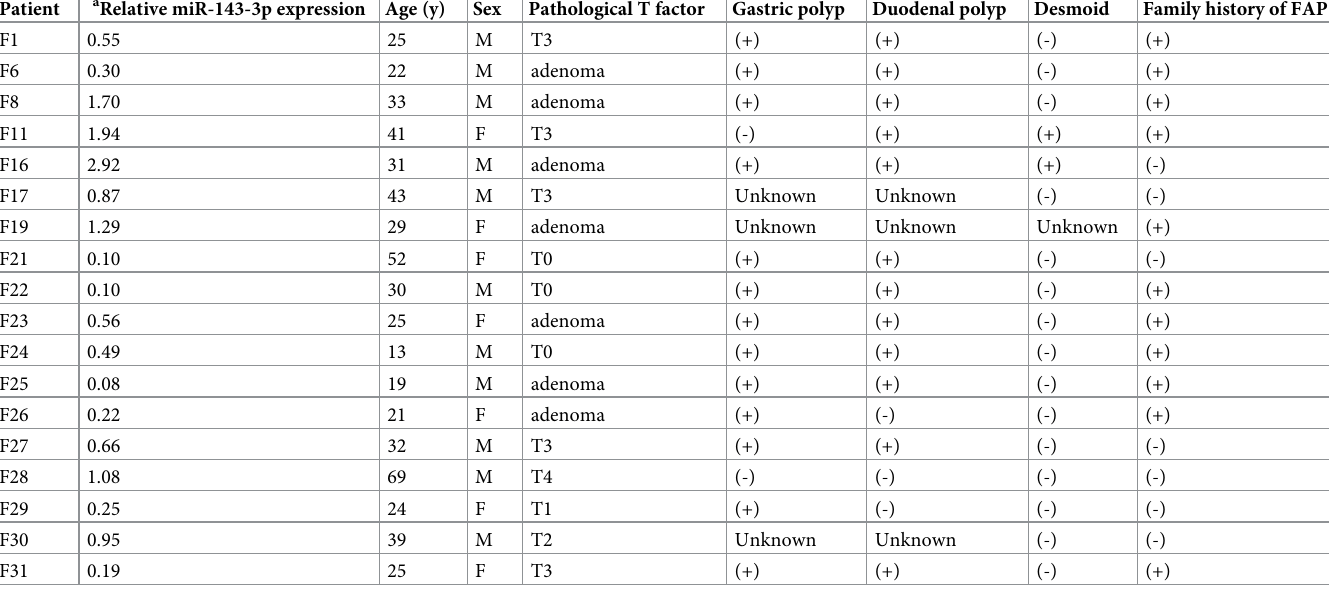
Table 3. Relative miR-143-3p expression levels in colonic tumor.